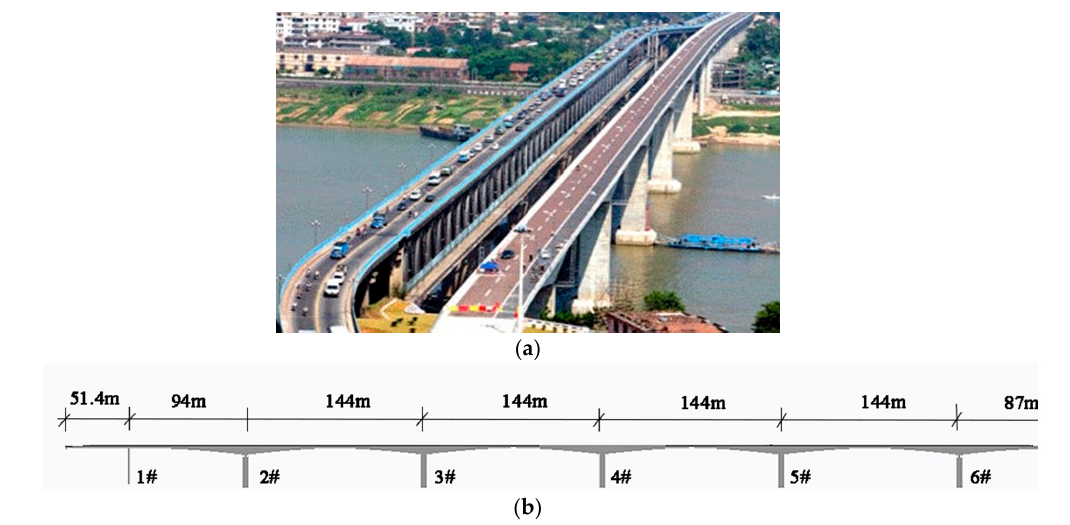
Figure 14. Xijiang Bridge: ( a ) photograph of the bridge; ( b ) schematic diagram of the structure. Table 3. Properties of each part of the Xijiang Bridge in Zhaoqing, China.